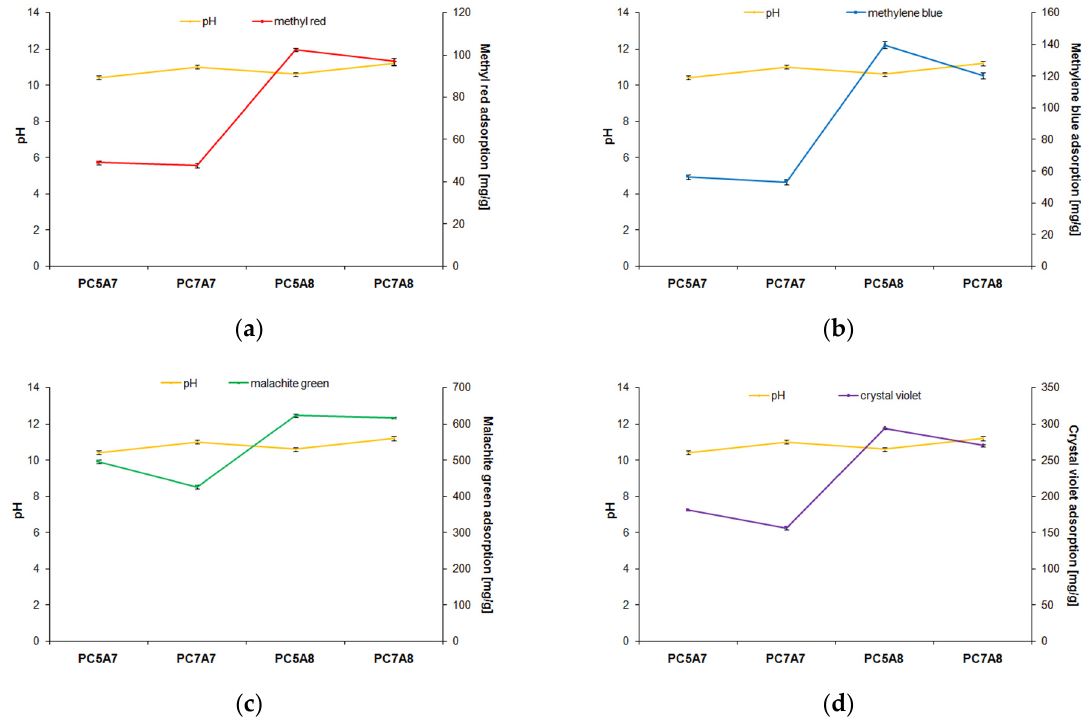
Figure 13. Dependence of dyes adsorption capacity on surface pH value: ( a ) methyl red, ( b ) methylene blue, ( c ) malachite green, ( d ) crystal violet.